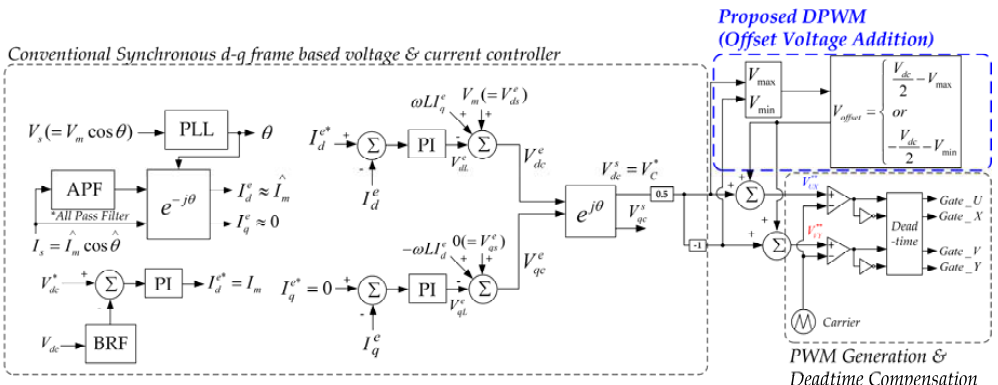
Figure 8. Overall control diagram of single-phase PWM converter using proposed DPWM. 2009